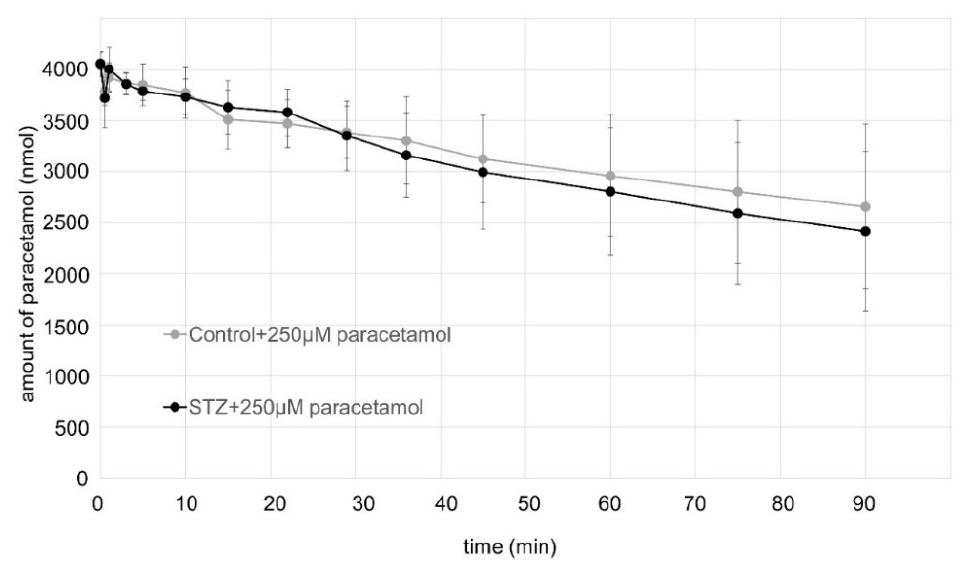
Figure 2. Time course of the disappearance of paracetamol in rat small intestinal perfusate during perfusion of the jejunal loop with isotonic medium containing 250 µ M paracetamol. Each value represents the mean of 5 independent experiments ± standard error.